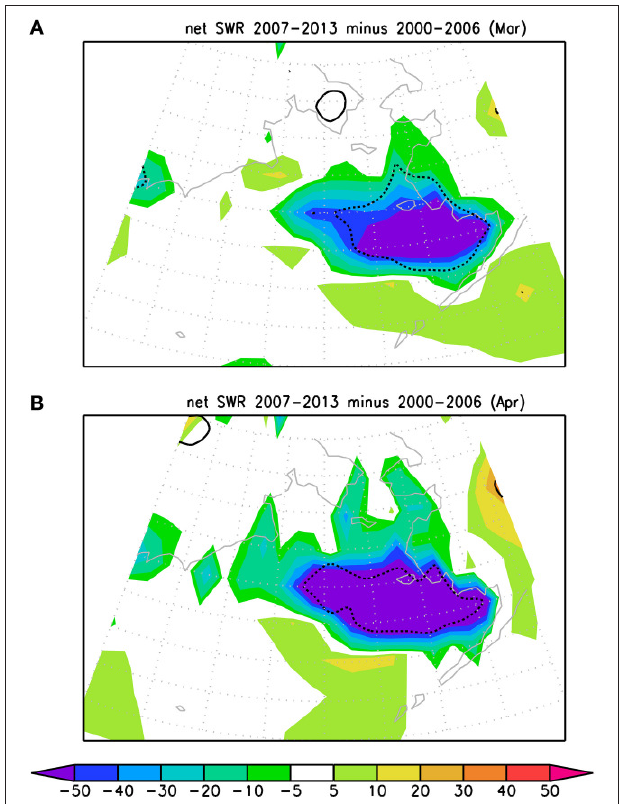
FIGURE 8 | Difference of surface net shortwave radiation (W/m 2 ) in March (A) and April (B) derived as mean during 2007–2013minus that during 2000–2006. The thick lines denote that the difference between 2007–2013 and 2000–2006 is significant at the 99% confidence level according to the Student t -test.